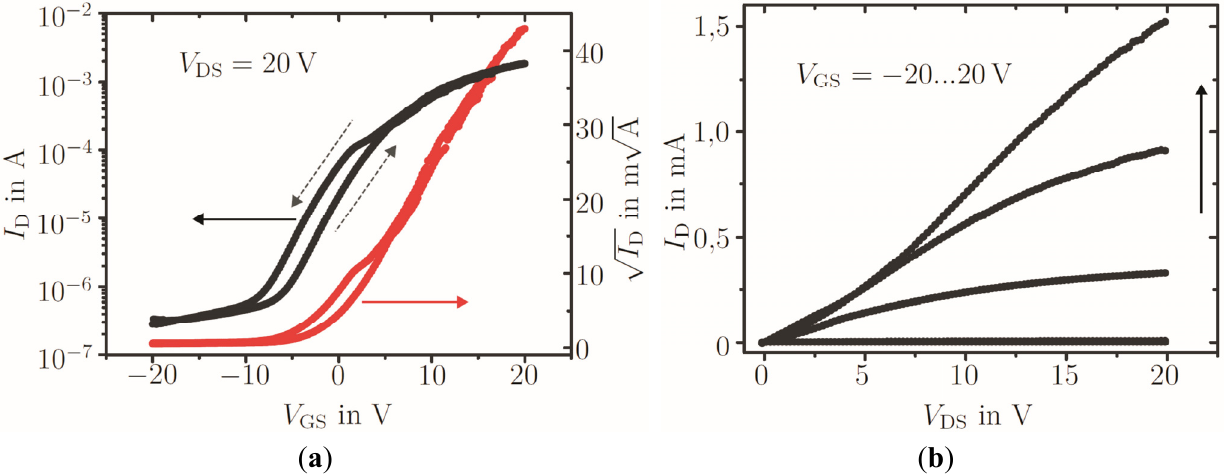
Figure 15. ( a ) Transfer and ( b ) output characteristics of an inverted staggered ZnO nanoparticle TFT (L = 8 µm, W = 16000 µm and t ox = 53 nm). © 2015 IEEE. Reprinted, with permission, from